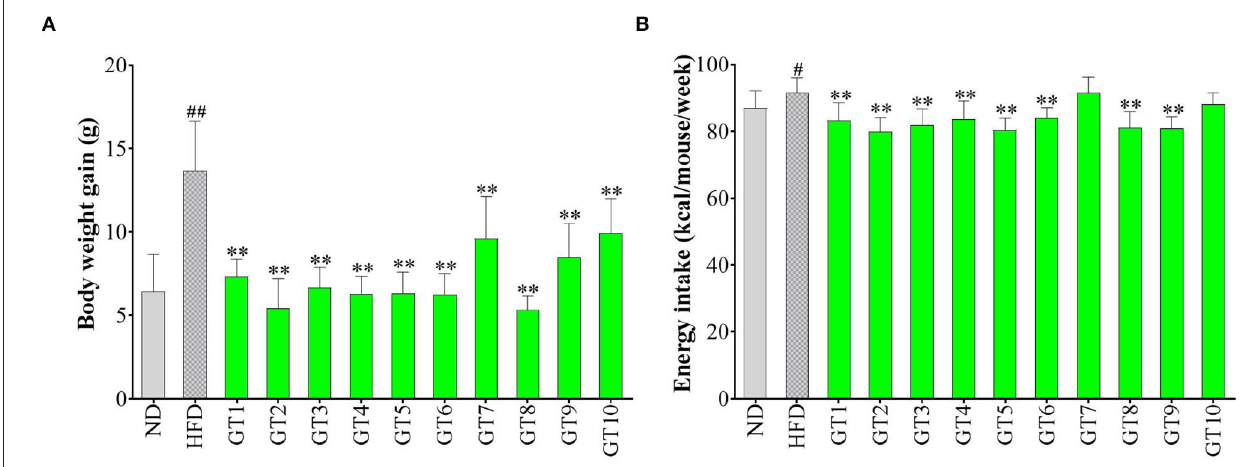
FIGURE 1 | Effects of green teas on body weight (BW) gain (A) and energy intake (B) . # p < 0.05, ## p < 0.01, the model group vs. the control group; ** p < 0.01, the green tea groups vs. the model group. ND, normal diet; HFD, high-fat diet. GT1, Dianqing Tea; GT2, Jieyang Chaoqing Tea; GT3, Fenggang Zinc-Selenium -Enriched Tea; GT4, Liping Xiang Tea; GT5, Taiping Houkui Tea; GT6, Xihu Longjing Tea; GT7, Chaoqing Green Tea; GT8, Selenium-Enriched Chaoqing Green Tea; GT9, Selenium-Enriched Matcha; GT10, Seven Star Matcha.